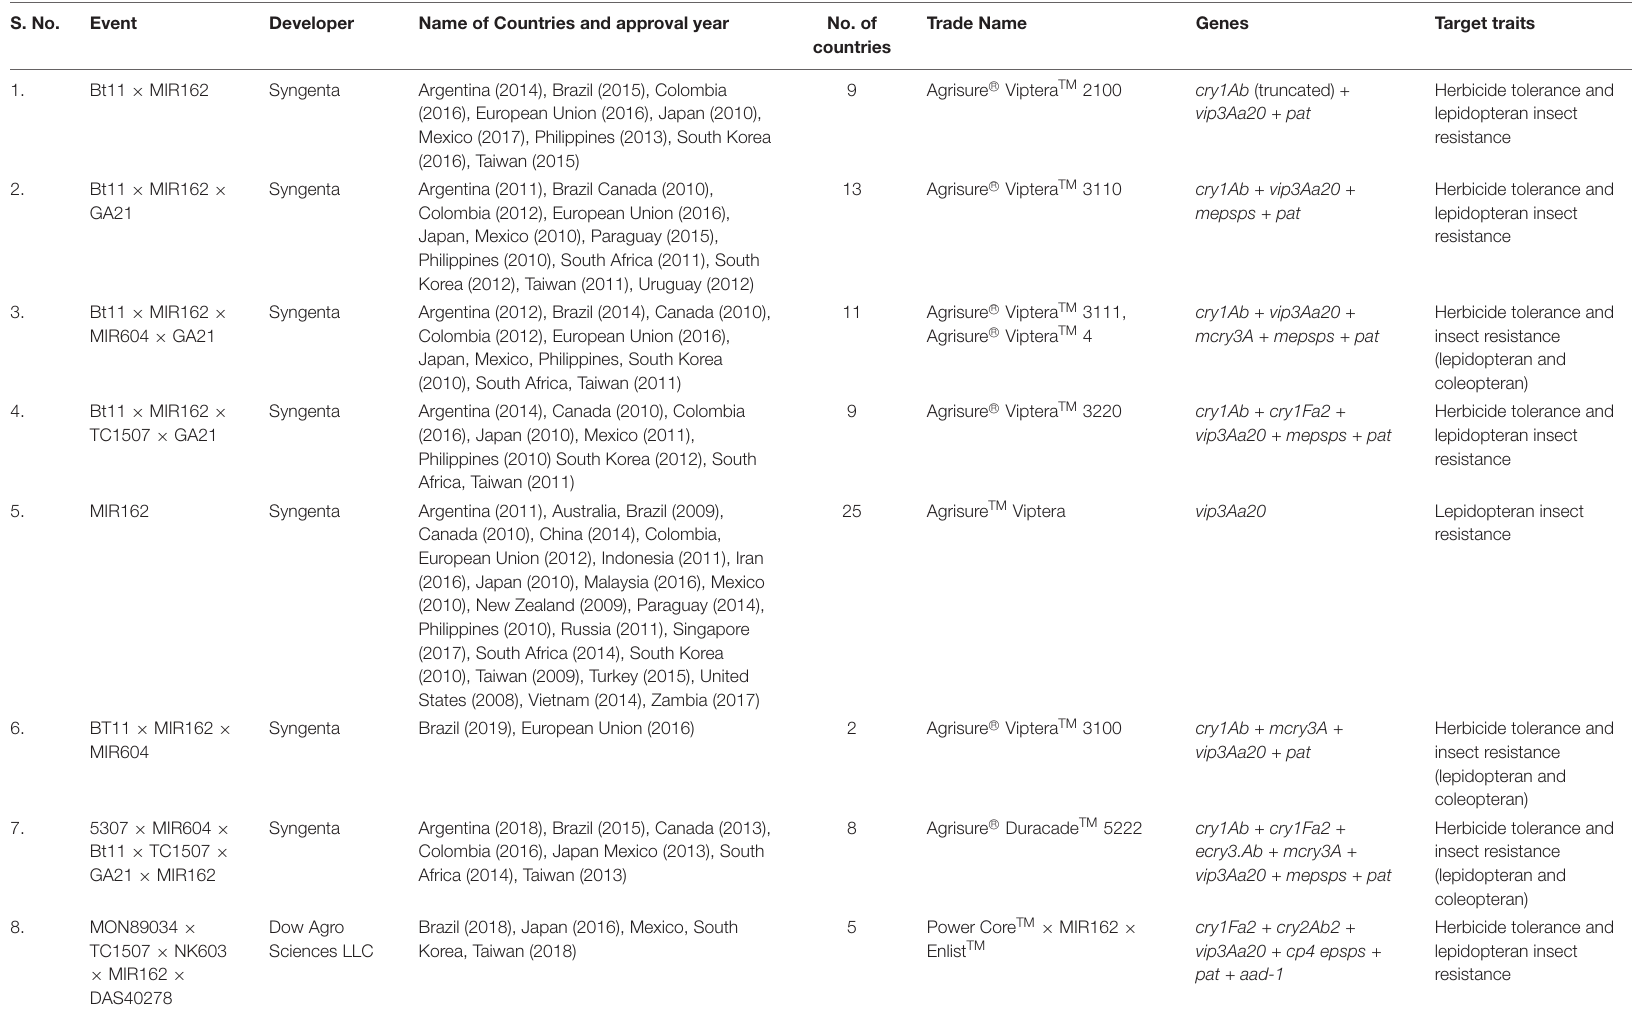
TABLE 6 | List of approved events containing Vip3A proteins in commercial Bt maize in different countries. S.